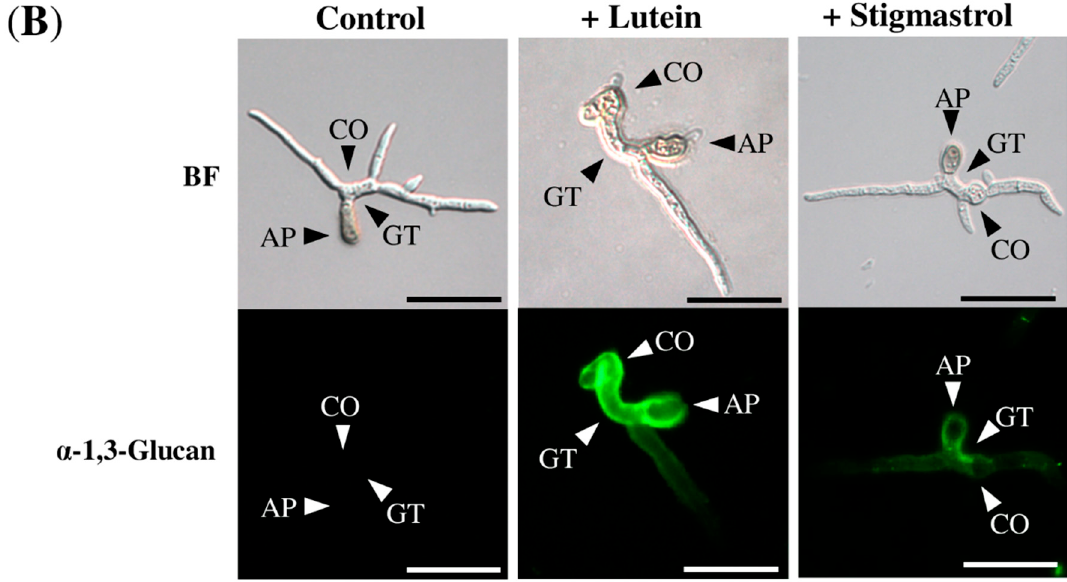
Figure 3. Immunofluorescent detection of α -1,3-glucan on the cell wall of Colletotrichum fioriniae in the presence of active substances from carrot leaves. ( A ) The structures of lutein and stigmasterol; ( B ) Accumulation of surface α -1,3-glucan in the presence of lutein (10 μ M) and stigmasterol (50 μ M). The fungal conidia were incubated in 0.24% potato dextrose broth (PDB) containing lutein/stigmasterol dissolved in 1% ethanol and 0.1% dimethyl sulfoxide (DMSO). Control; 0.24% PDB solution containing 1% ethanol and 0.1% DMSO. BF, bright field microscopy; “ α -1,3-glucan”, fluorescence microscopy. AP, appressoria; CO, conidia; GT, germ tubes. Scale bar, 20 μ m. More than 300 germinated fungal conidia were observed for each sample. Representative images at 12 h after incubation are shown. Experiments were repeated three times.